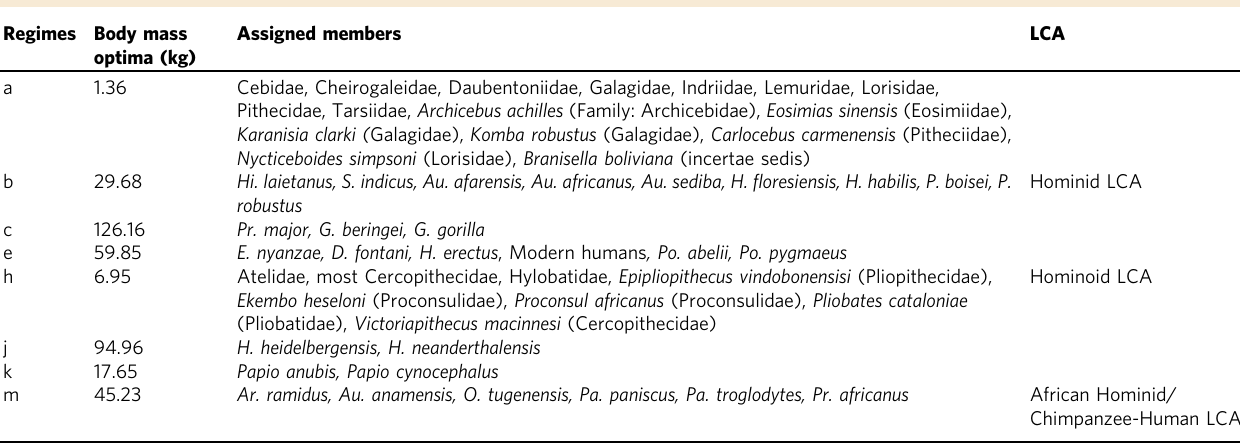
Table 2 Selective regimes, estimated body mass optima, and groups assigned to each regime for primates including fossils with fossil families in